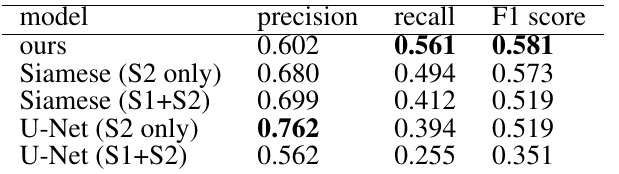
Table 1. Performance of the evaluated change detection models on the ONERA test split. The proposed multi-modal network outperforms the considered baseline and is strongest in terms of both recall and F1 score.